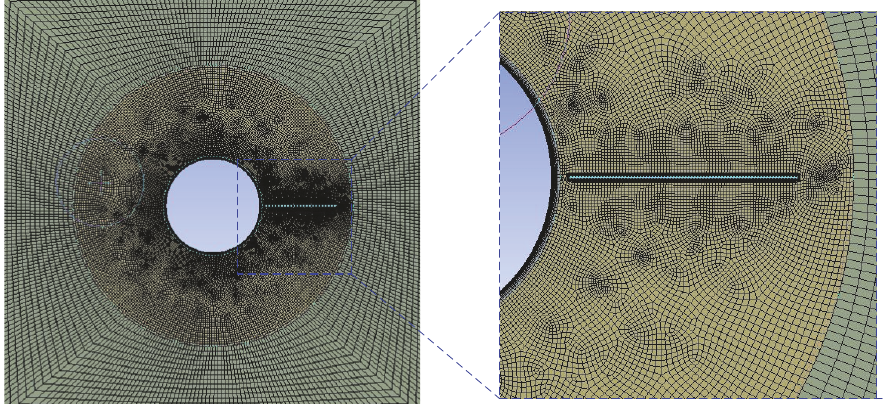
Figure 5: Mesh diagram of UMP and plate.